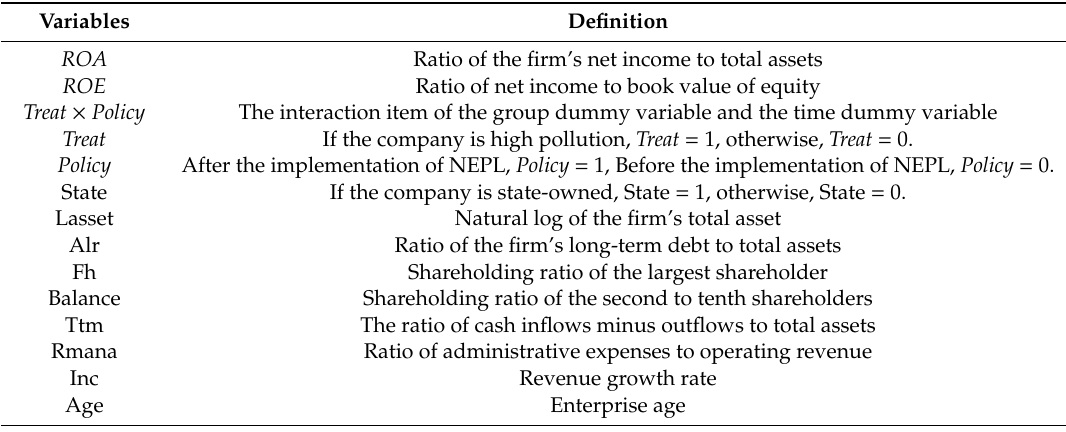
Table 1. Summary of the definitions of